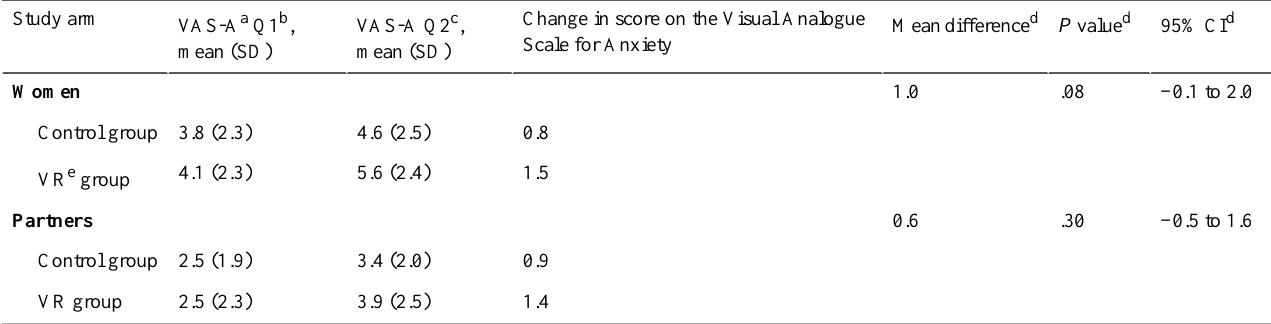
Table 2. Difference in the Visual Analogue Scale for Anxiety value at time point 2 (at admission) between the virtual reality and the control groups for both women and their partners (difference calculated using the Student t